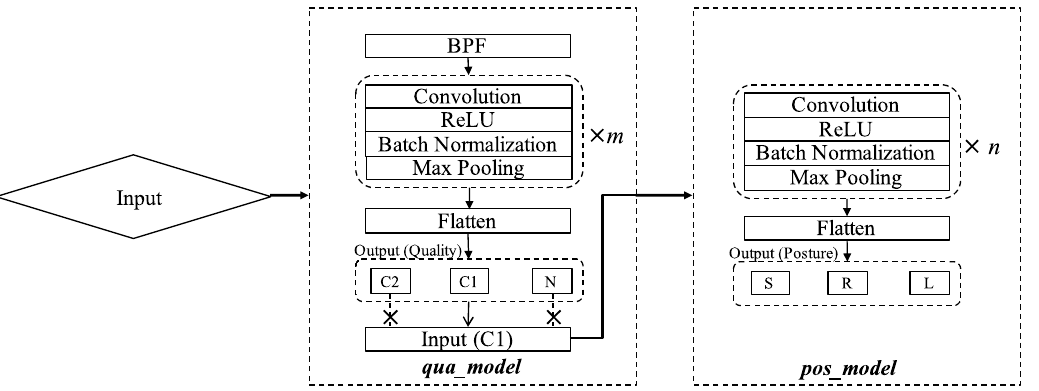
Figure 5. The workflow of the framework consisting of signal preprocessing and CNN-based classification. C1 samples, classified by the qua_model, were then fed to the pos_model for position classification. The italic m and n represent the best numbers of Conv layer in the two models.